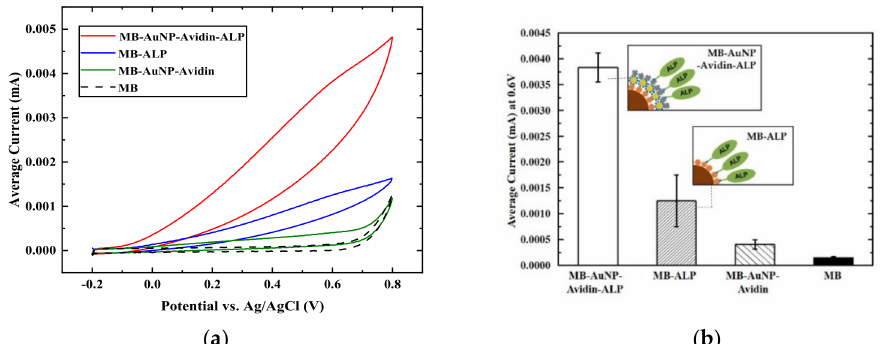
Figure 3. Analysis of signal enhancement of AMB: cyclic voltammetry (ranging from − 0.2 V to 0.8 V) results of ( a ) AMB or MB labeled with ALP (red and blue lines, respectively). AMB or MB without ALP labeling were controls (green and dotted black lines, respectively); ( b ) current values for the tested samples at 0.6 V were recorded from Figure 3a; data = mean ± standard deviation, n =